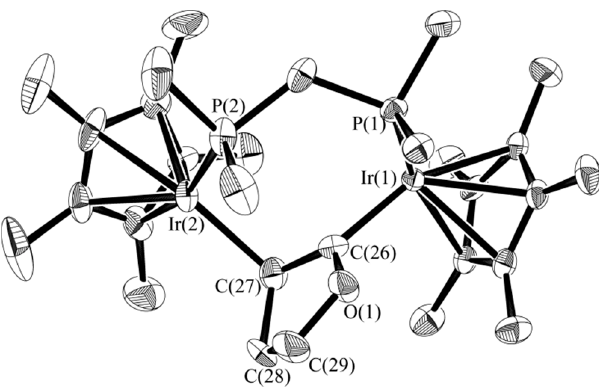
Figure 1. Binding modes in the complex 3 .